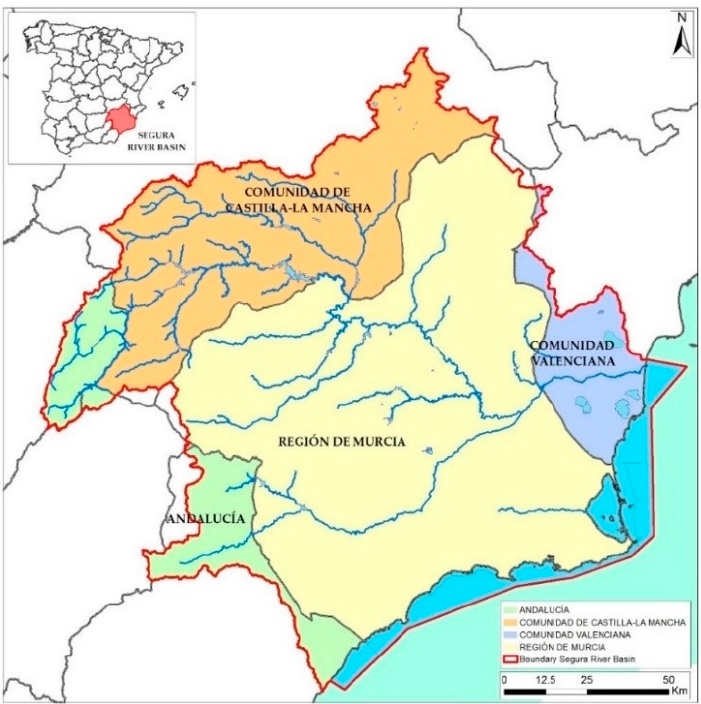
Figure 1. Study situation map. Source: Special Drought Plans, own elaboration. The distribution of rainfall is highly heterogeneous, both spatially and interannually, as the autumn and spring months are characterised by high levels of rainfall while the